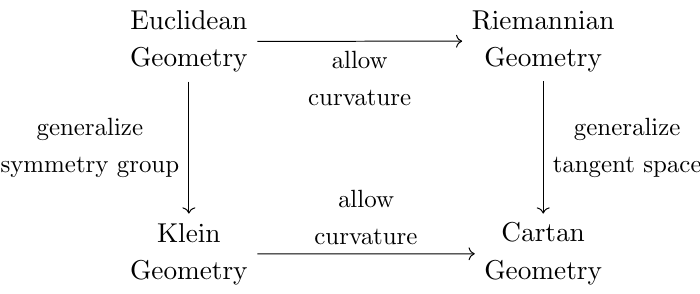
Figure 2 . Cartan geometry is a generalization of both Riemannian geometry, by allowing the tangent spaces to be di(cid:11)erent from R n , and of Klein geometry, by nontrivially gluing together Klein